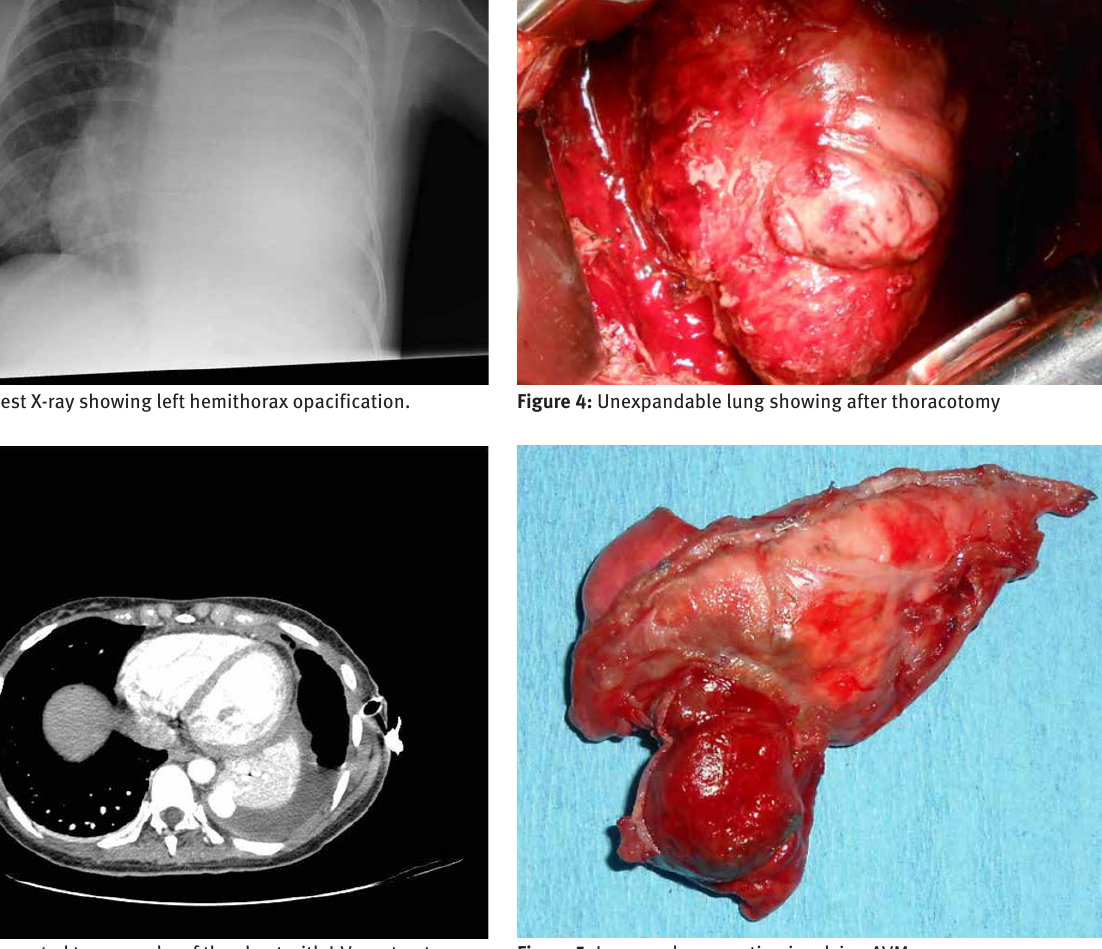
Figure 5: Lung wedge resection involving AVM